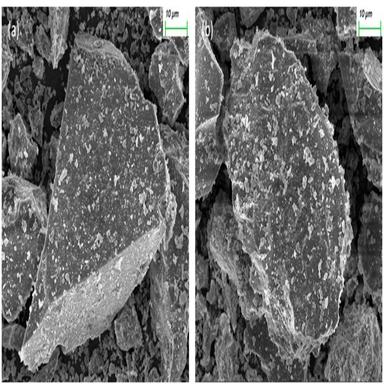
Morphology of MBA particles by SEM (1000×magnification, with an accelerating voltage of 10 kV).